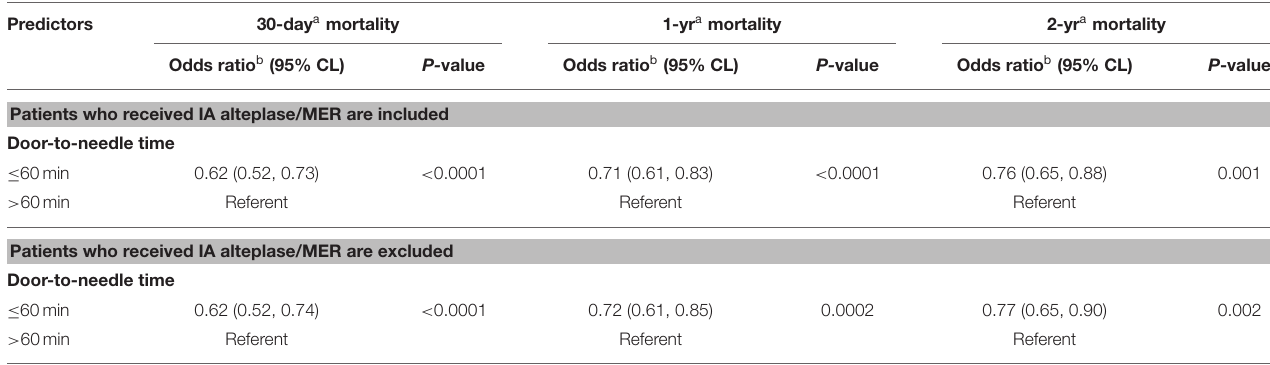
TABLE 5 | Relative risk of mortality among ischemic stroke patients treated with intravenous alteplase, GCASR January 2008–June